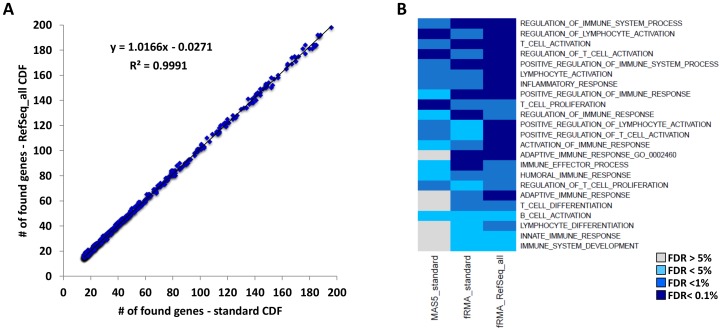
Immune gene set enrichment analysis results from the comparison of samples with and without lymphocitic infiltration in the INT FFPE dataset.(A) Number of genes composing each gene set that was found in the standard CDF compared with the number of genes found in the RefSeq_all CDF. (B) Heatmap representing positive enrichment significance for the immune gene sets after processing the data with three different pipelines.